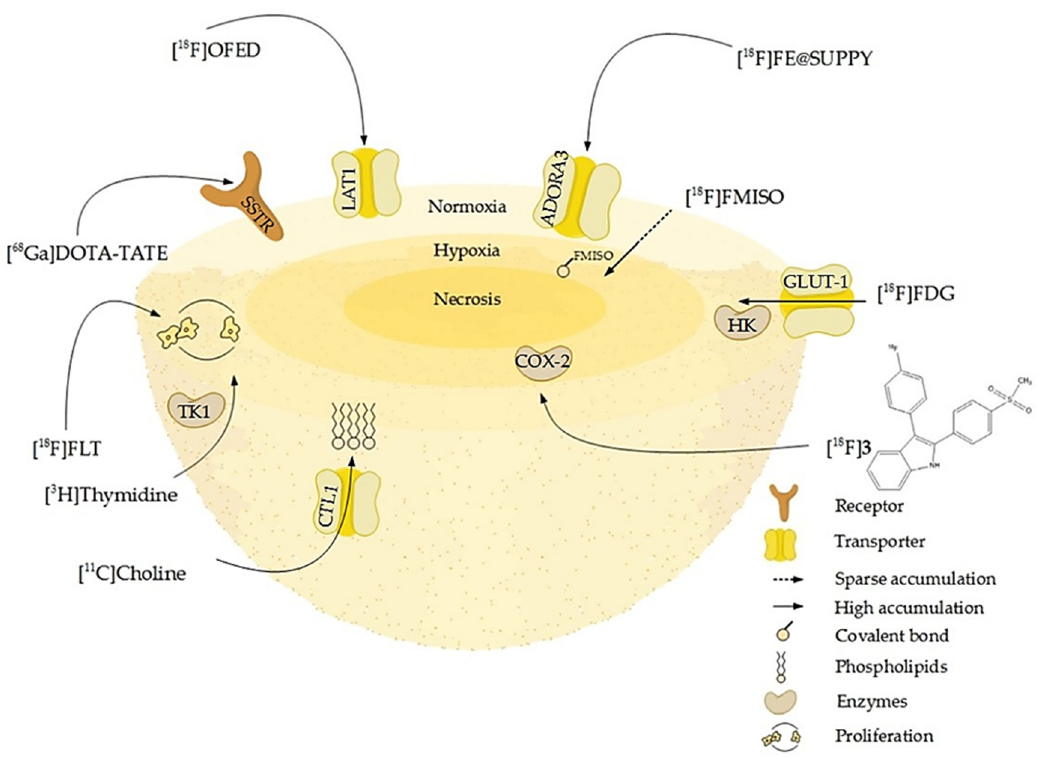
Figure 5. Schematic overview of molecular or pathophysiologic targets for well-established and novel radiotracers: some of them address membrane-bound cell receptors or transporters like somatostatin receptors (SSTR), adenosine receptors A 3 (ADORA3), or L-amino-acid transporters (LAT1). Other tracers such as [ 11 C]choline are taken up by transporters as the choline transporter-like protein (CTL1) and incorporated into the phospholipids of proliferating cells. The enzyme substrates [ 3 H]thymidine and [ 18 F]FLT target proliferating cells by incorporation into the DNA via for example the cytosolic thymidine kinase (TK-1). Enzyme inhibitors, portrayed here by [ 18 F]3, a radiolabeled selective cyclooxygenase 2 inhibitor, in turn accumulate in areas of high enzyme concentration and activity. The radiolabeled glucose derivative [ 18 F]FDG visualizes glucose turnover by glucose transport (GLUT-1) and hexokinase (HK) reaction and consequently the metabolic activity and viability of cells, which is high in the normoxic proliferating regions of the spheroid and lower in the hypoxic core. In contrast, [ 18 F]FMISO binds to macromolecules in a hypoxic environment and thus accumulates in the hypoxic core (Table 4).